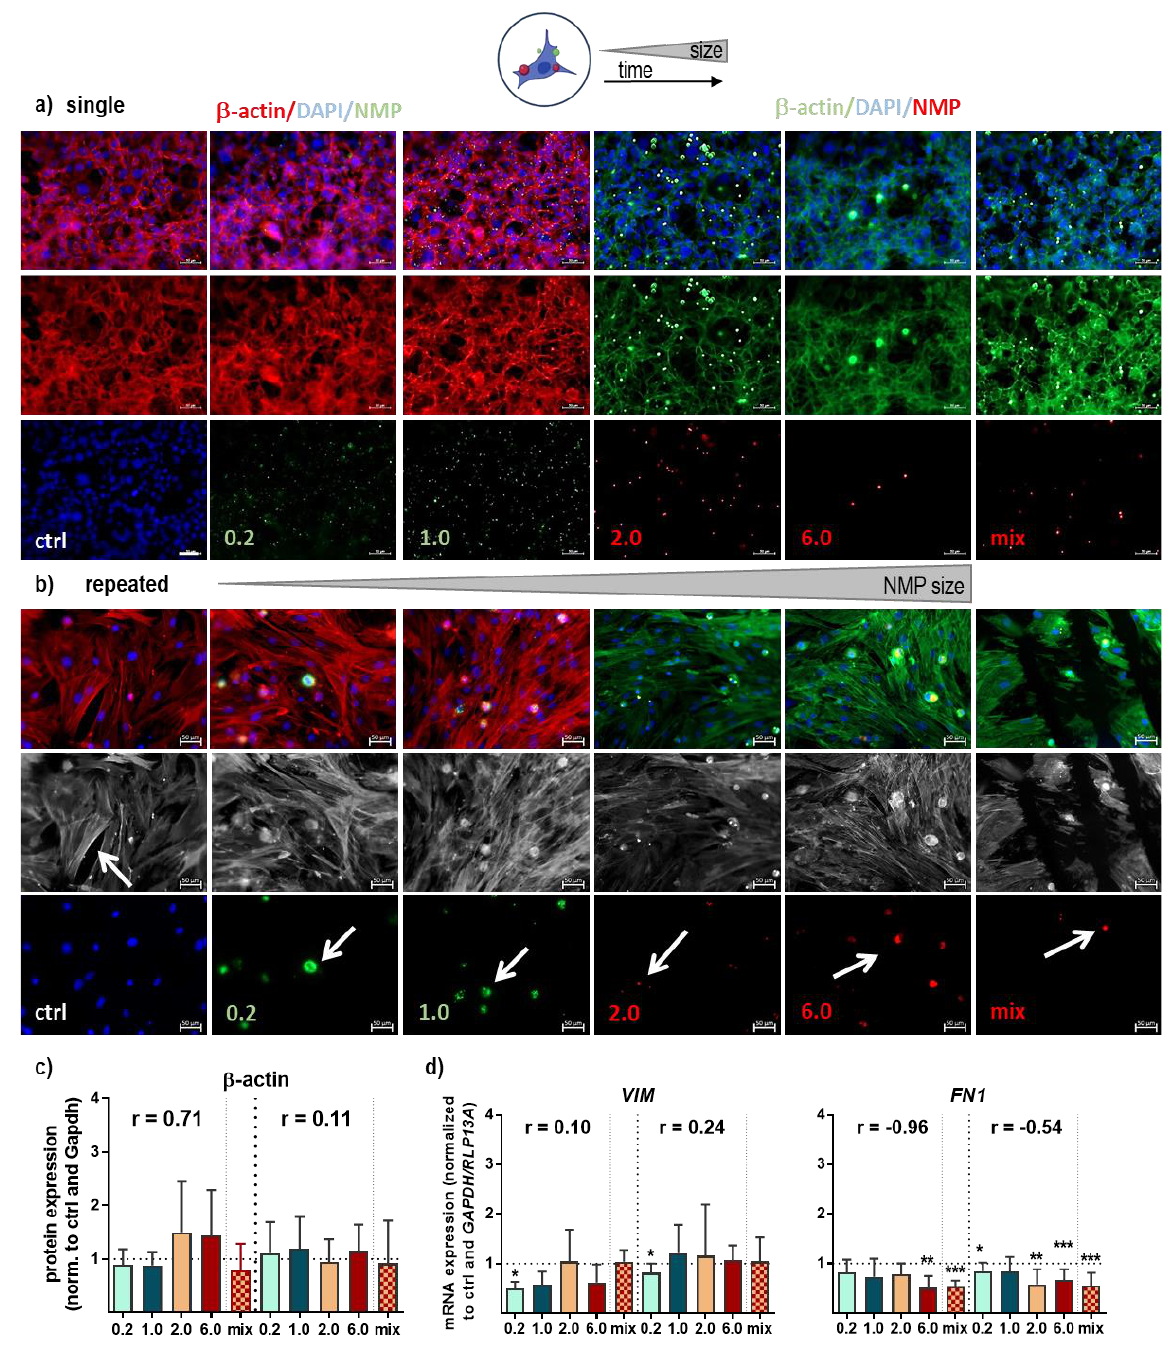
Figure 4. Alteration of cell structure following NMP exposure. ( a , b ) Study scheme and representative images showing cells that were grown on glass coverslips, incubated with selected NMP, fixed, and subjected to fluorescent labeling of actin stress fibers using FITC (green) or FlashRed-phalloidin (red) after single ( a ) and repeated NMP exposure (( b ), arrows showed transient breakdown of the cytoskeleton in cells with NMP) with or without nuclear counterstaining (DAPI, blue); ( c ) protein expression level of β -actin measured by WES; ( d ) gene expression levels of VIM , and FN1 quantified by qPCR. Data were normalized to GAPDH/RLP13A and untreated controls (ctrl) and presented as mean + SE. Statistical analysis was done by unpaired, two-tailed Student ’s t -test with * p < 0.05, ** p < 0.01, and *** p < 0.001. Scale bars are 50 µ